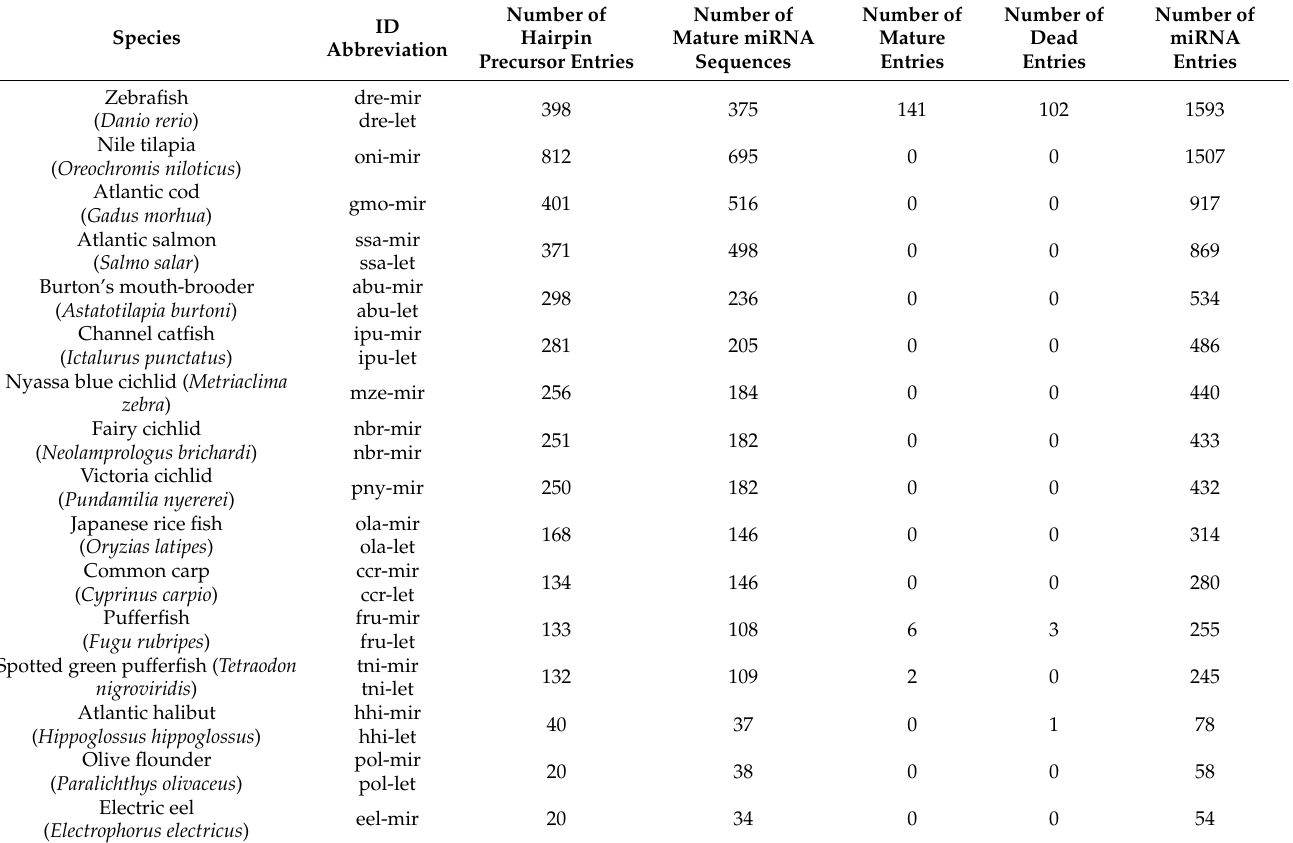
Table 1. Browsed miRNA information from the teleost miRBase including species, ID abbreviation, number of hairpin precursor entries, mature miRNA sequences, mature entries, dead entries and miRNA entries (http://www.mirbase.org/index.shtml, accessed on 7 June 2018). 17 January